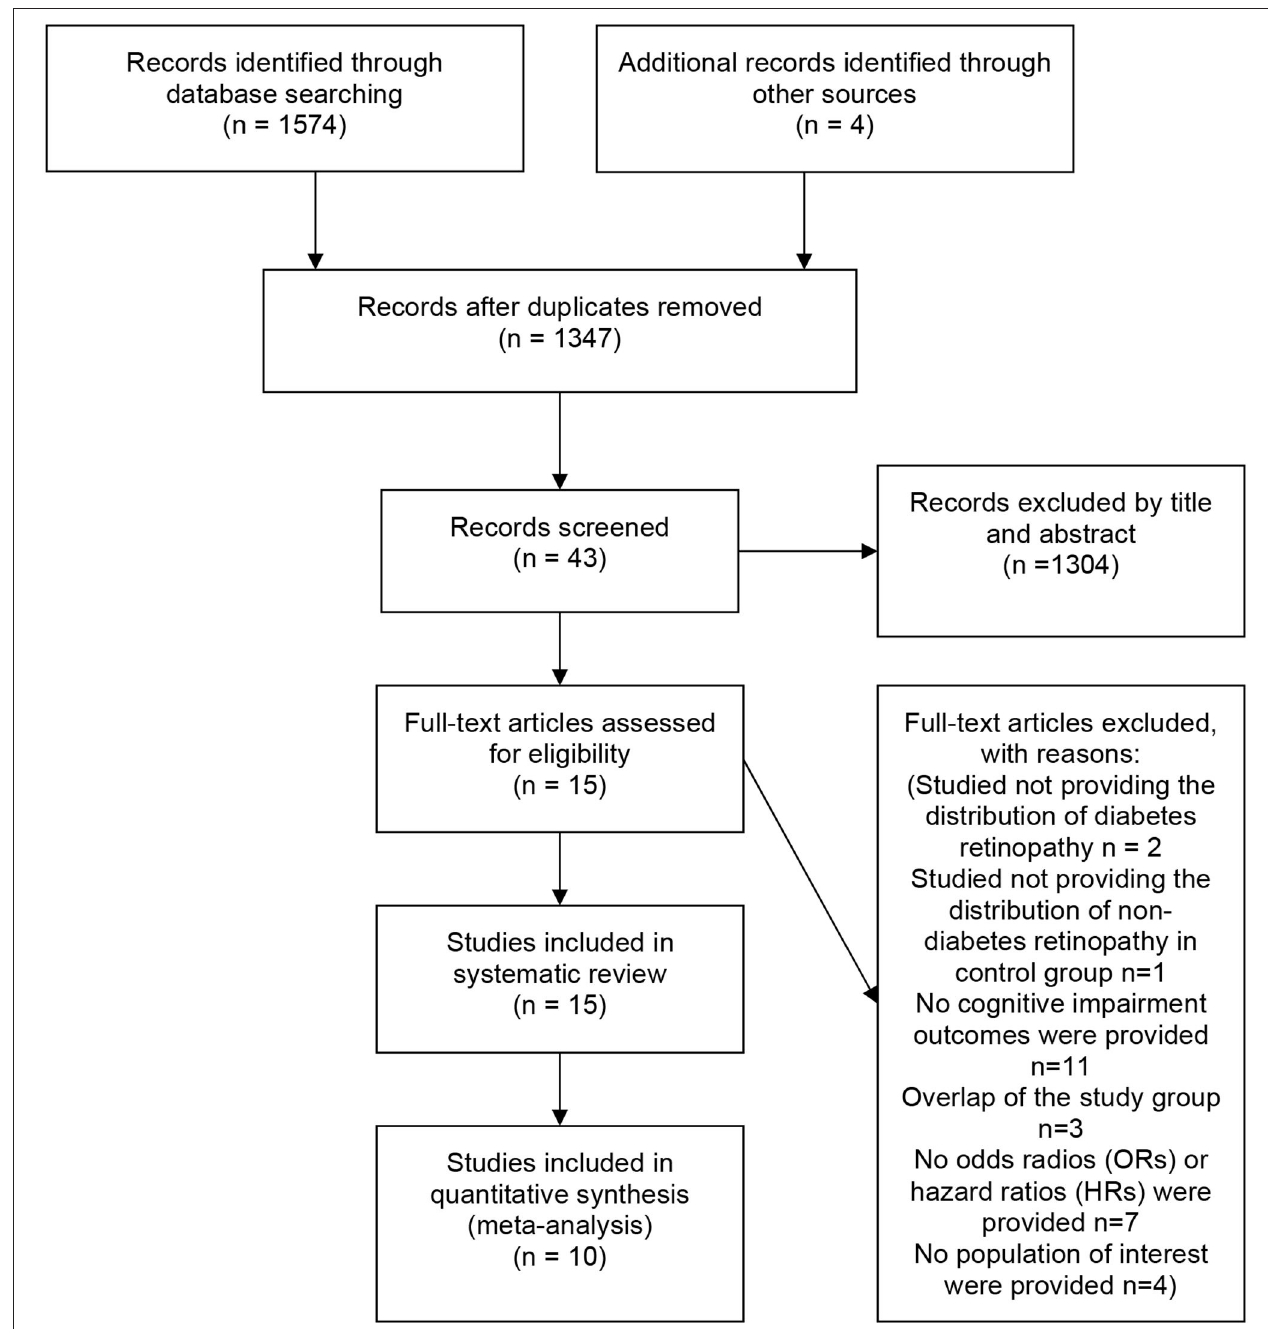
FIGURE 1 | PRISMA flow diagram of this systematic review and meta-analysis.